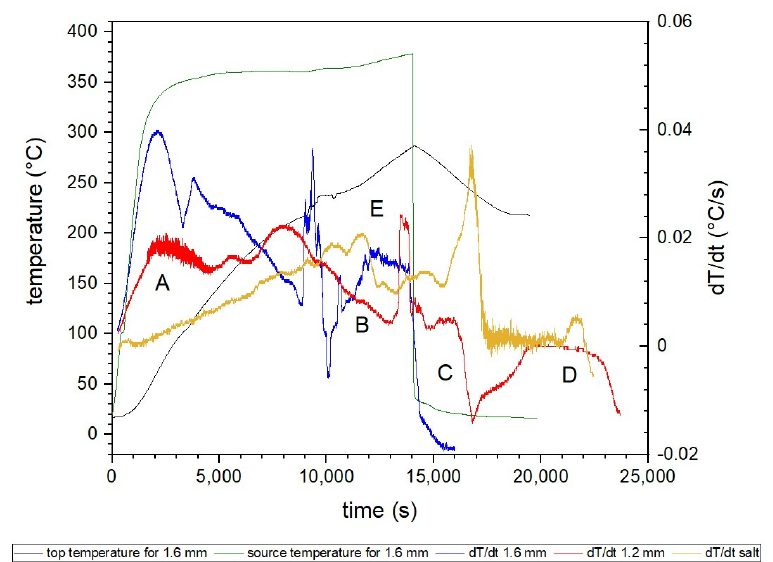
Figure 6. Derivative curves for the investigated cases and the temperature course of the heat source and the top (h = 87 mm) thermocouple for the 1.6 mm insert. Letters symbolize areas as follows: A—the first peak responsible for heat conduction through the insert, B—phase